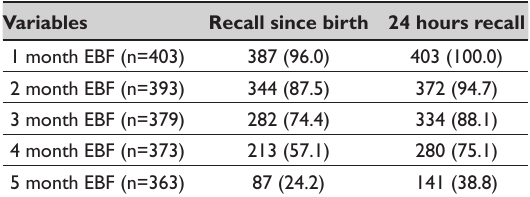
Table 3: Prevalence of exclusive breastfeeding